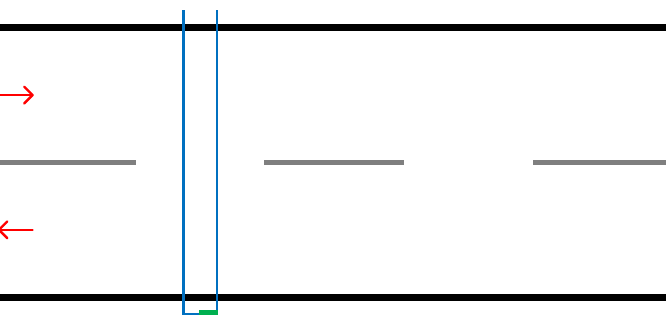
Figure 1. Illustration demonstrating implementation of pneumatic road tubes. The blue lines represent the road tube and the green box representing the counting device.